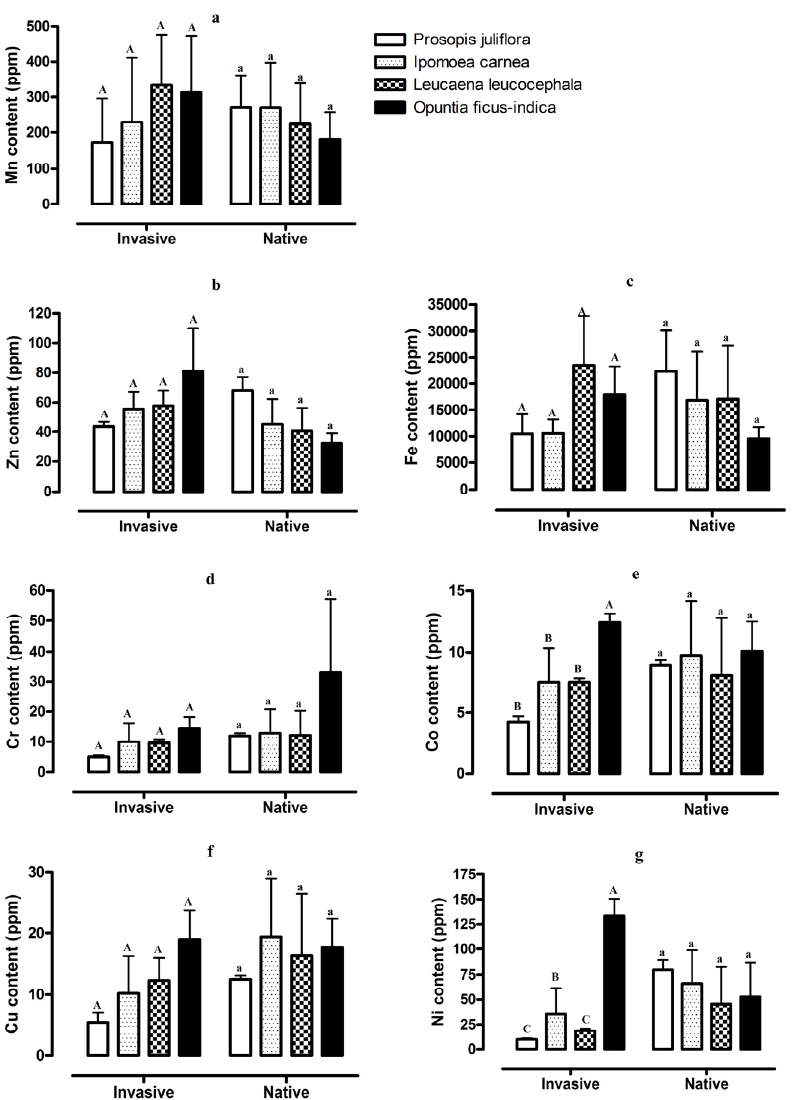
Figure 2. Values of soil microelements, Mn ( a ), Zn ( b ), Fe ( c ), Cr ( d ), Co ( e ), Cu ( f ), and Ni ( g ), from stands invaded by Prosopis juliflora , Ipomoea carnea , Leucaena leucocephala , and Opuntia ficus-indica and adjacent stands of native vegetation in southwest Saudi Arabia. Different capital letters indicate significant differences among the soils from stands invaded by four invasive plant species and different lower-case letters indicate significant differences among the soils from stands of native vegetation ( n = 6, p <